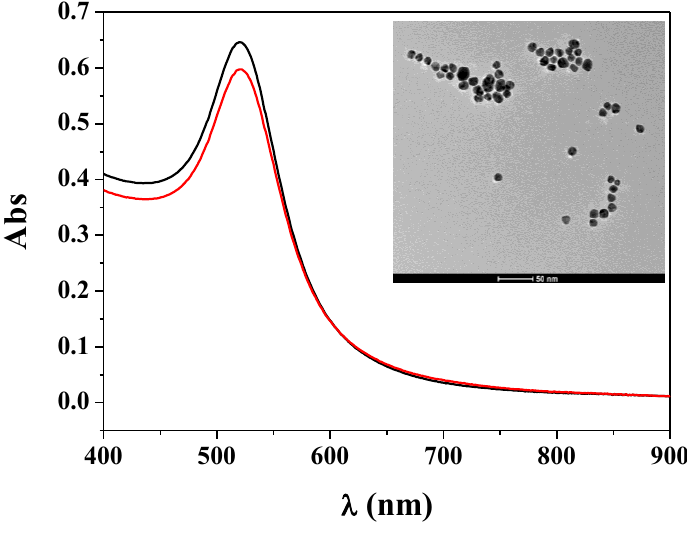
Figure 1. UV/vis absorption spectra of the citrate-stabilized gold nanoparticles (AuNPs) (black curve) and the synthesized ferrecene-derivatized peptides and 4-mercaptophenylboronic acids (Fc–MBA)–AuNPs (red curve). The inset shows the TEM image of the